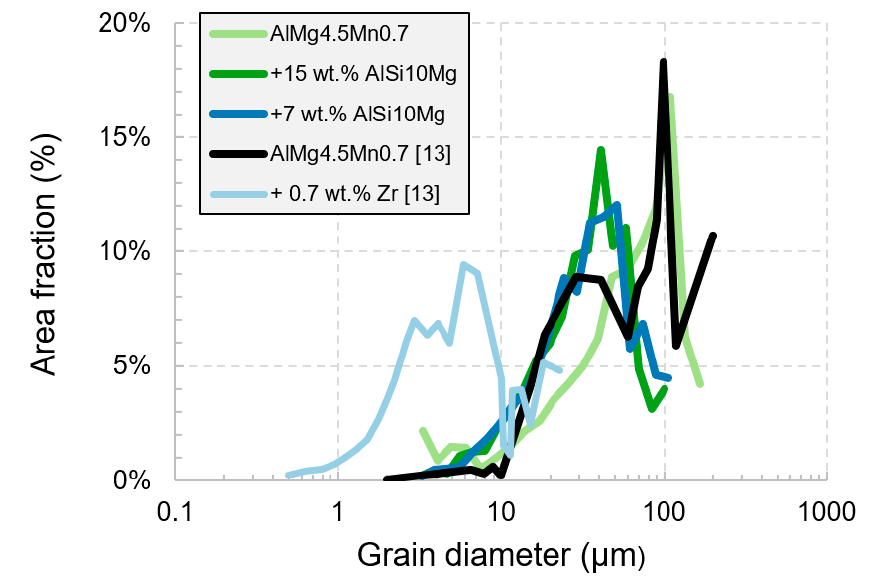
Figure 8. Histogram of the area fraction over the grain diameter. The data was extracted from the EBSD measurement Figure 7.